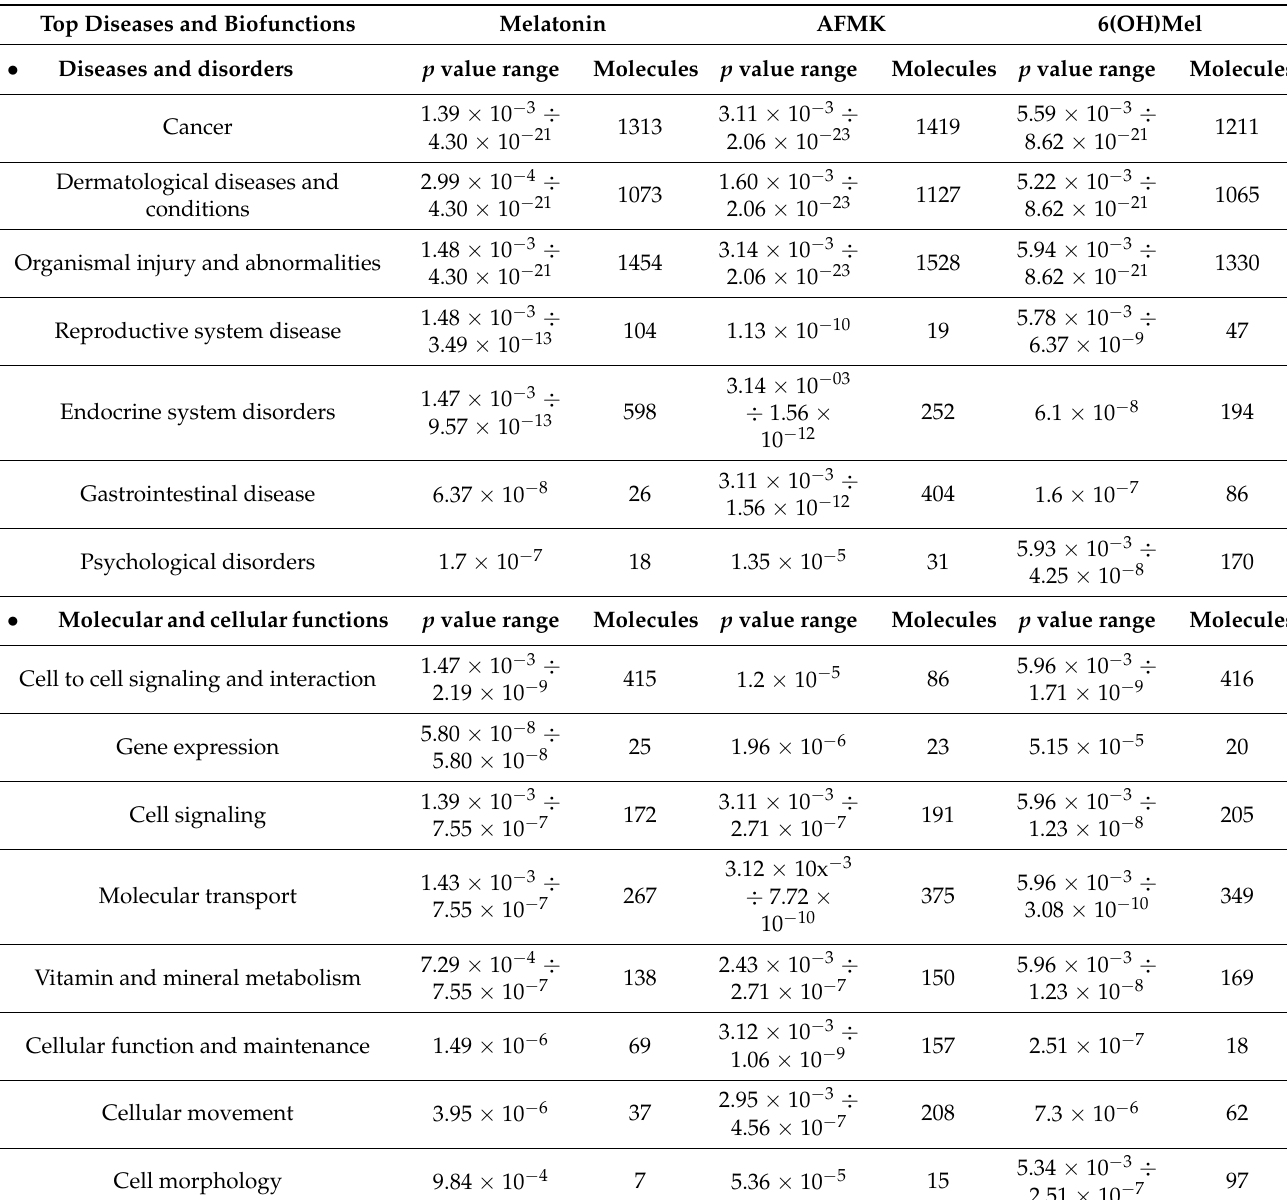
Table 1. Summary of Ingenuity Pathway Analysis (IPA) for top common classes of diseases and biofunctions regulated by melatonin and its metabolites based on the data obtained from primary human epidermal